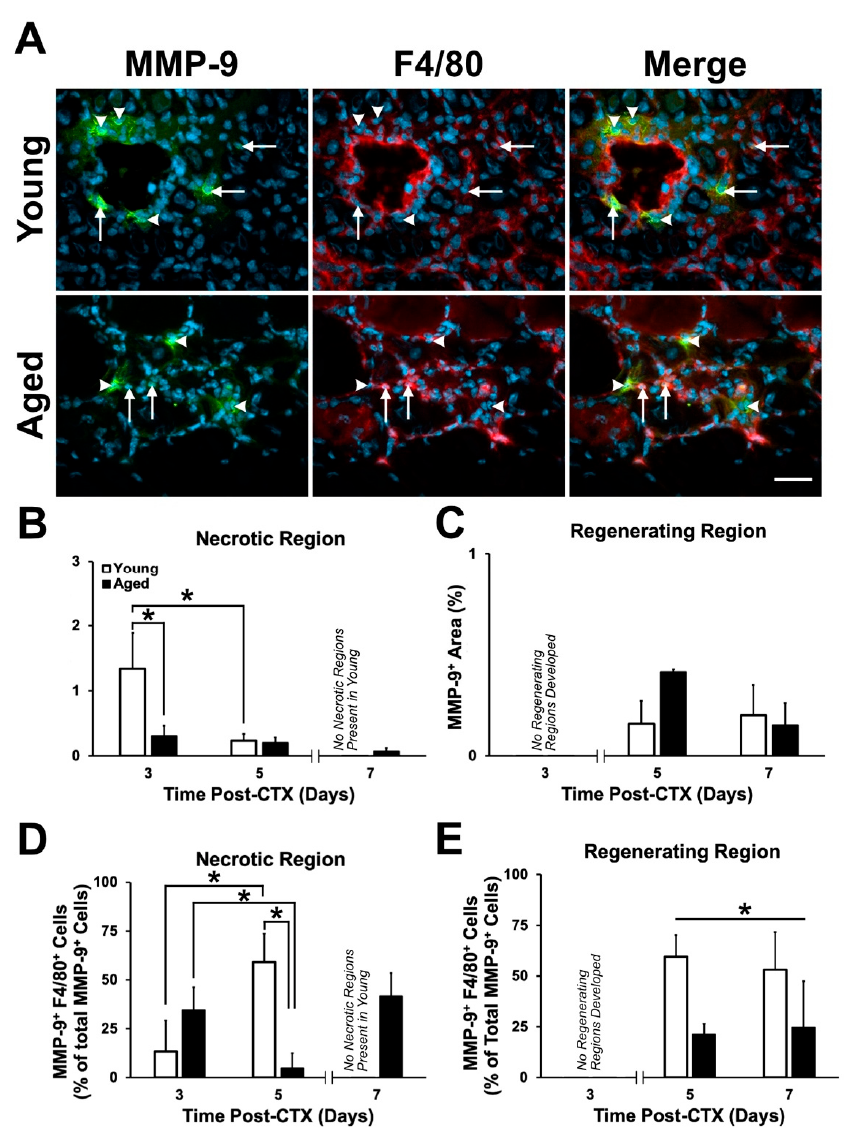
Figure 8. MMP-9 expression was elevated acutely following damage in young muscle. ( A ) Immunostaining of MMP-9 (green), F4 / 80 (red), and DAPI (blue). Arrows indicate F4 / 80 +/ MMP-9 + cells and arrowheads indicate F4 / 80- / MMP-9 + cells five days post-CTX. ( B ) A significant interaction between age and recovery time point in MMP-9+ area following damage was detected within the necrotic regions ( p = 0.004). Simple main effect post-hoc analyses demonstrated a significant greater MMP-9 expression within young muscle at three days following damage ( p < 0.001). MMP-9 expression declined significantly from three to five days following damage ( p < 0.001). ( C ) No significant di ff erences in MMP-9-positive area were observed in the regenerating regions of young and aged muscle ( p > 0.05). ( D ) A significant interaction between age and recovery time point on MMP-9 +/ F4 / 80 + cells were detected following damage ( p = 0.004). A simple main effects post-hoc analysis showed significantly greater macrophage-specific (F4/80+) MMP-9 expression in the necrotic regions of young muscle five days following damage ( p = 0.009). Additionally, macrophage-specific MMP-9 expression increased significantly between three and five days in young, however, the opposite was observed in aged muscle ( p = 0.026 and p = 0.031, respectively). ( E ) A significant main e ff ect of age was found in the regenerating regions, with young muscle displaying a greater percentage of macrophage-specific MMP-9 expression compared to aged muscle ( p = 0.008). * in ( B ) and ( D ) indicates significance from the simple main e ff ects post-hoc analyses ( p < 0.05). * in ( E ) indicates a main e ff ect of age. n = 4–5 per group. Data presented are means ± standard deviation. Scale bar represents 100 µ